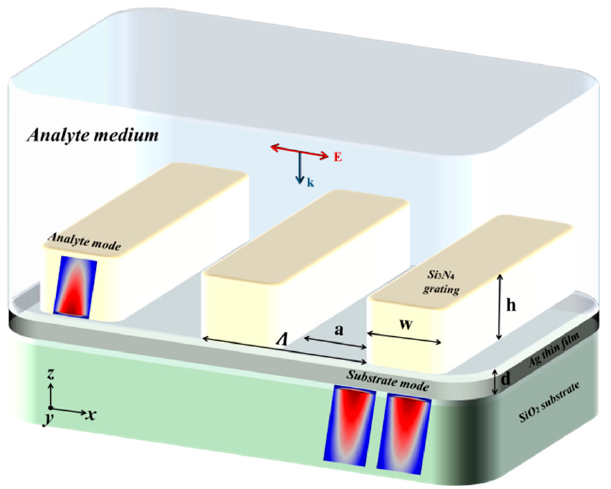
Figure 3. Schematic diagram of the self-referenced sensor based on TDGTMF geometry.